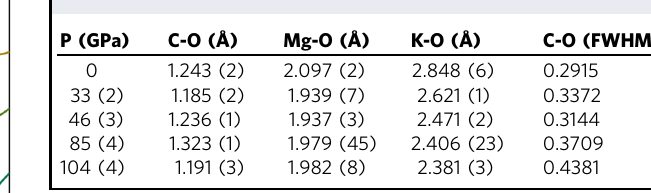
Table 1 Statistical information on the fi tting of the PDF peaks as a function of